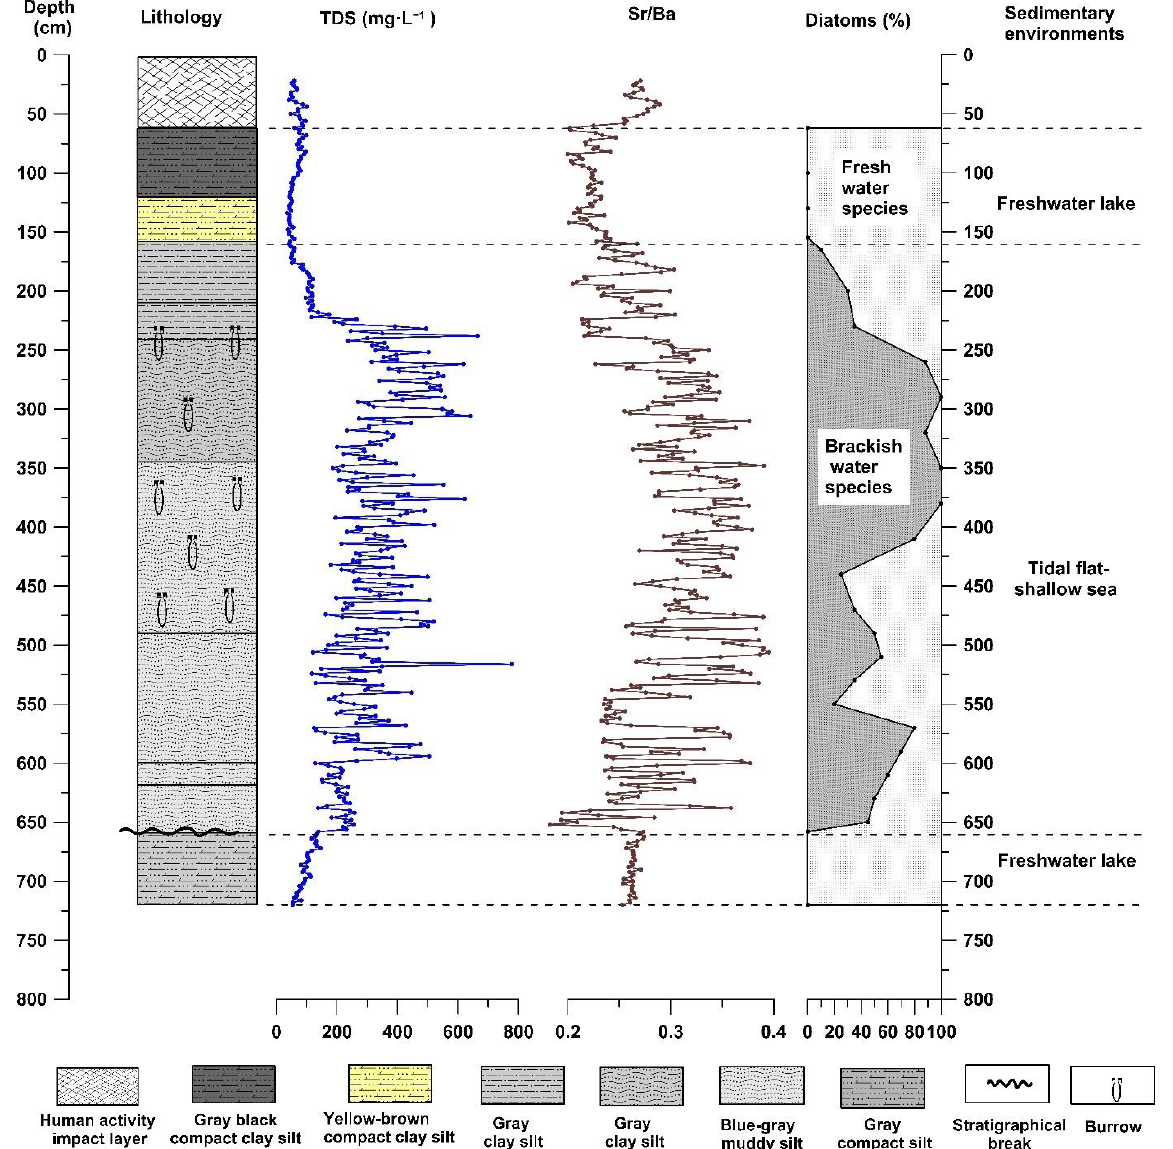
Figure 9. Comparison of lithology, TDS, Sr/Ba, and diatoms of CYK section and sedimentary environment.